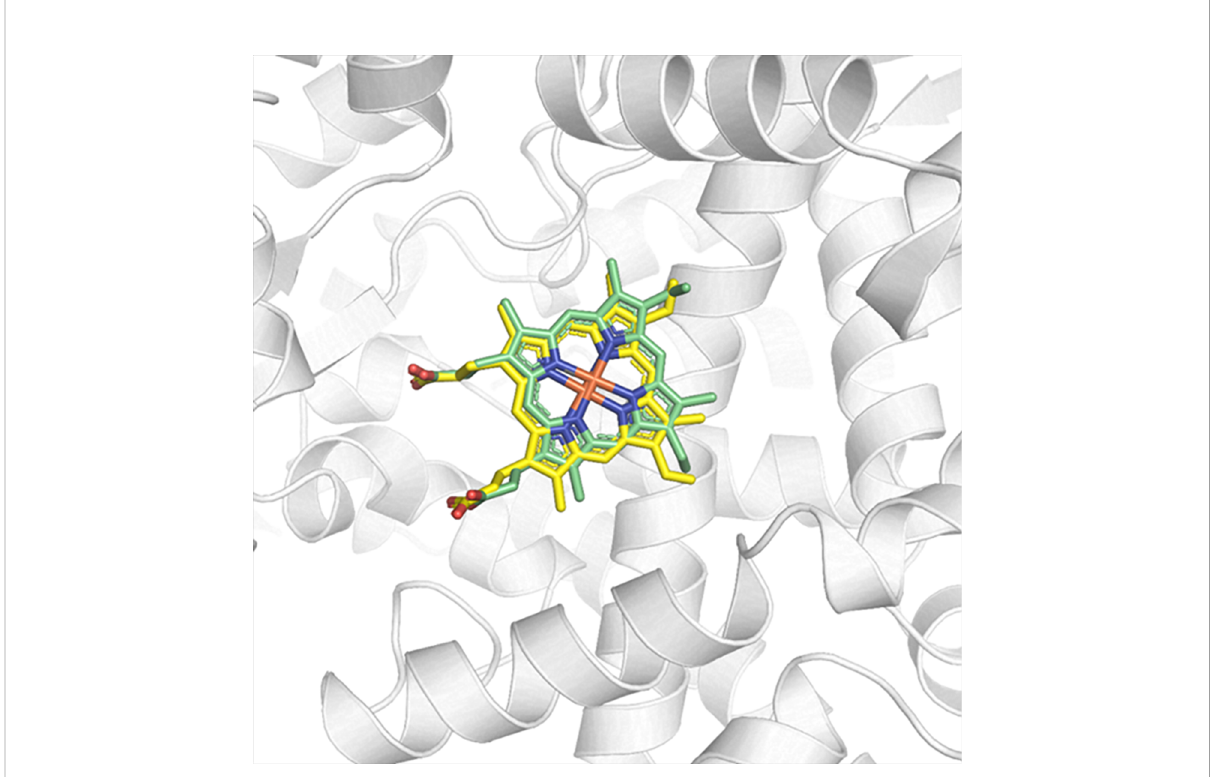
FIGURE 6 Redocking of the co-crystallized ligand HEM on the active site of CYP51 (PDB ID 3TIK). In green, the best pose of the co-crystallized ligand generated by the ChemPLP function and, in yellow, its crystallographic